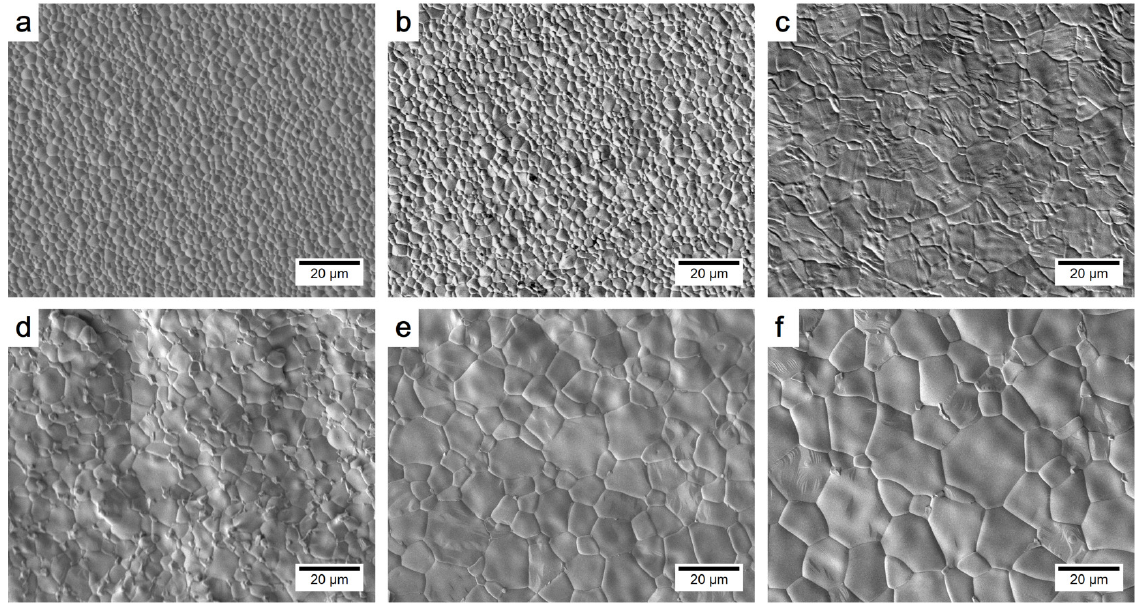
Figure A5. SEM images of the Pr 1– x Sr x (Cr,Mn,Fe,Co,Ni)O 3– δ ( x = 0–0.5) membrane surface. ( a ) x = 0; ( b ) x = 0.1; ( c ) x = 0.2; ( d ) x = 0.3; ( e ) x = 0.4; ( f ) x = 0.5. The close contact